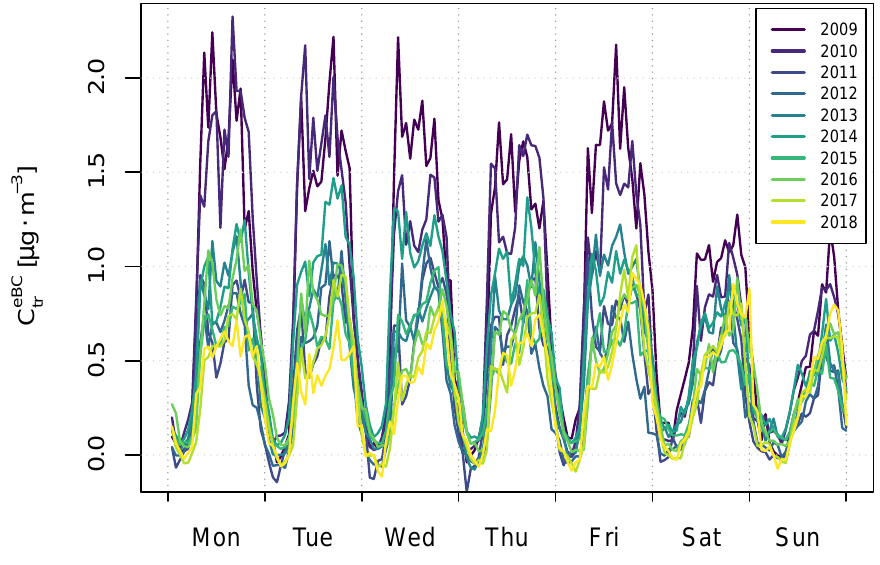
Figure 6. Weekly cycle of the median eBC traffic increment C eBC